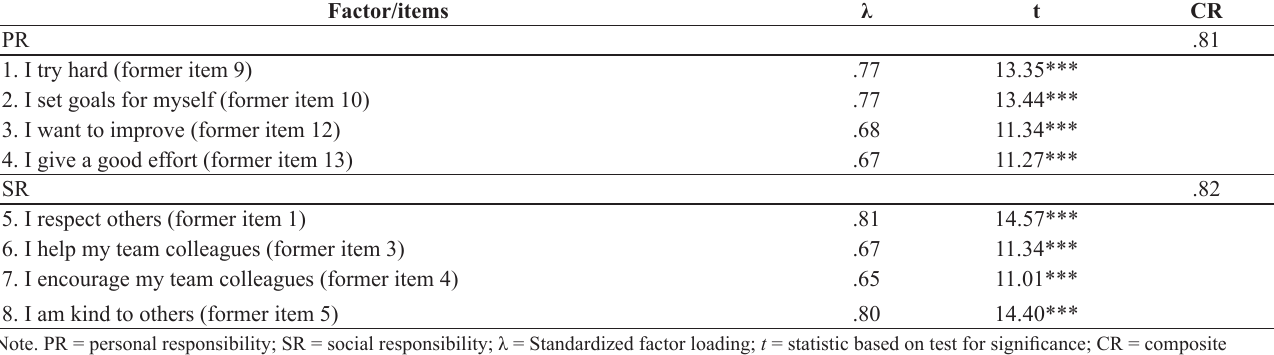
Table 2. Factor loadings and composite reliability (CR) of the refined dimensions of the